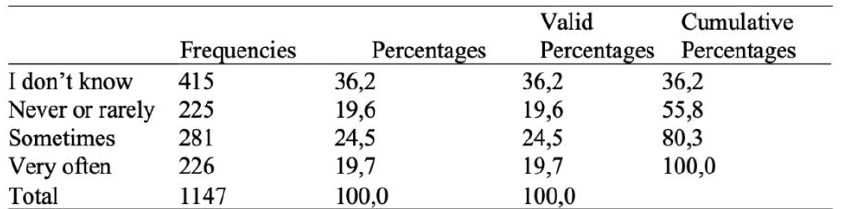
“How many times have teachers tried to stop the boys or girls who have hurt